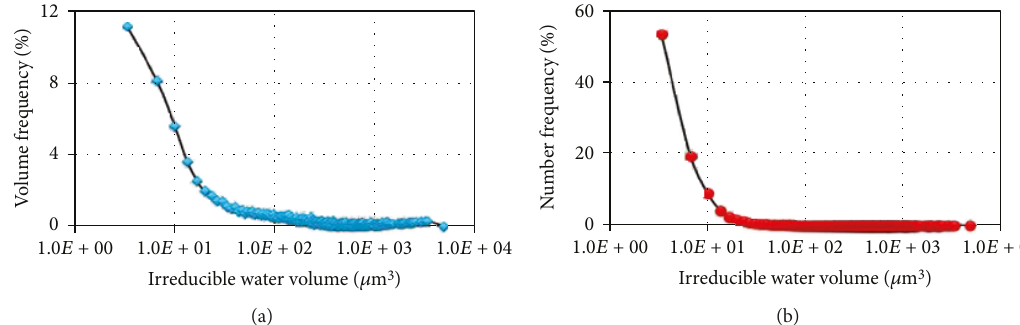
Figure 14: (a) Volume; (b) frequency number distribution of irreducible water blocks with di ff erent sizes in the throat system.